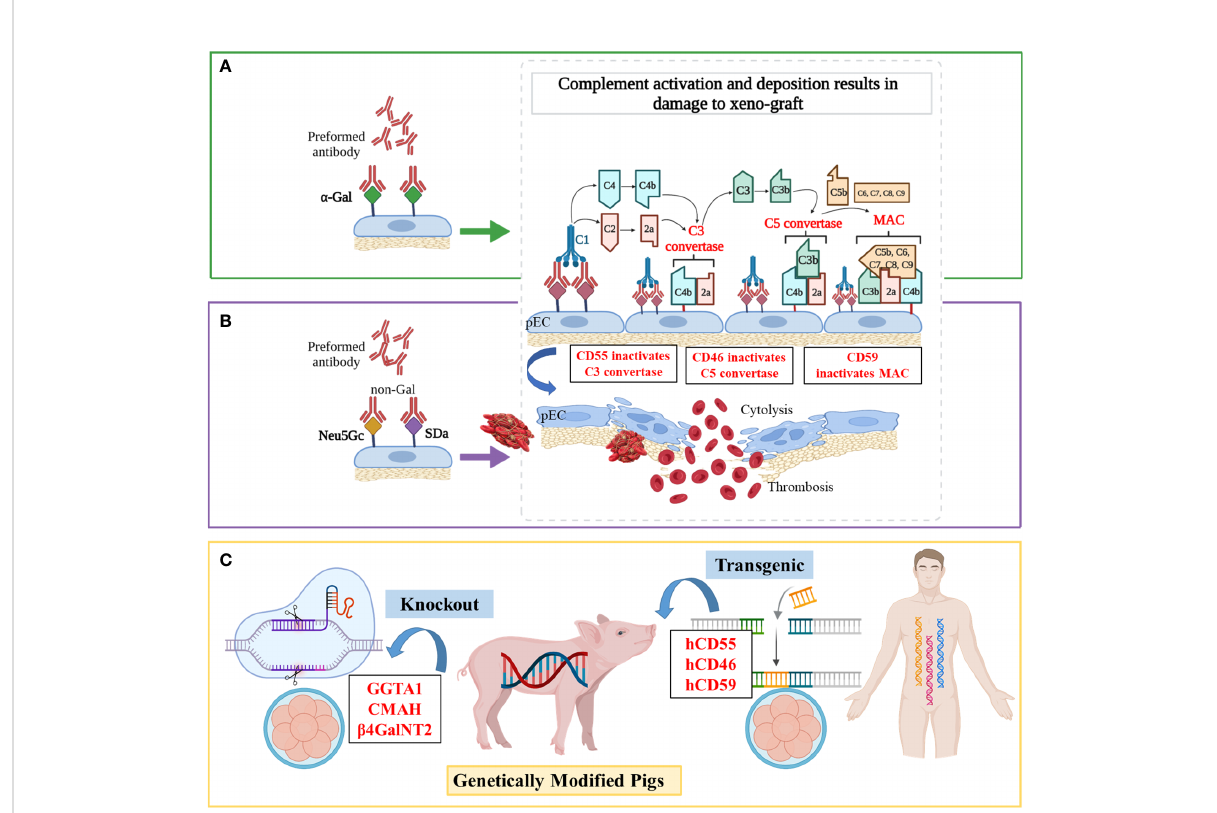
FIGURE 1 Mechanisms of antibody-mediated xenograft rejection and related genetic targets (A) Hyperacute rejection (HAR). In the classical complement activation cascade, the Fc regions of antibodies contact C1q, causing C1r and then C1s to autoactivate. Afterward, C4 and C2 are cleaved by activated C1s, resulting in the production of C4b2a (also known as C3 convertase). C3 convertase then cleaves C3 into C3a and C3b, with C3b binding to C4b2a to generate C4b2a3b (also known as C5 convertase). C5 convertase cleaves C5 into C5a and C5b, and then C5b is attached to C6, C7, C8, and multiple molecules of C9 to create the membrane attack complex (MAC), which ultimately causes cytolysis. (B) Acute humoral xenograft rejection (AHXR). AHXR can be induced by low levels of natural and elicited xenoreactive antibodies directed at non- a -Gal antigens (predominantly anti-Neu5Gc and -SDa), which also lead to complement activation via the classical pathway. The histopathology of AHXR is characterized by progressive destruction of the microvasculature (glomeruli and peritubular capillaries) and formation of fi brin-platelet thrombi. (C) Gene modi fi cations. To prevent HAR, CD59 , CD55 , hCD46 and GGTA1 were modi fi ed. To shun AHXR, CMAH -/- and b 4GalNT2 -/- knockout pigs were produced. Notably, these target genes were not edited individually, but in combination to obtained better tolerized pig